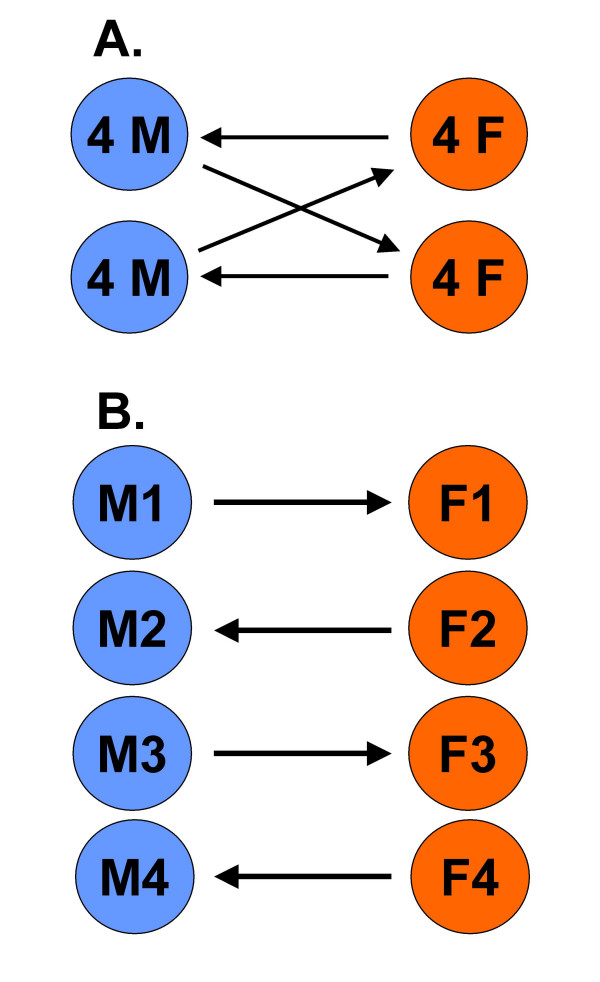
Experimental design. A total of 20 microarray hybridizations were performed, addressing biological variation through the use of 12 biologically independent samples for each sex, and technical variation through Cy3/Cy5 dye reversal as follows. (A) For each of the four embryonic stages (ed4, 6, 8 and 10), two samples per sex were generated by pooling equal amounts of total RNA from four individual male (M) or female (F) whole heads (ed4 and 6) or brains (ed8 and 10). Each RNA pool was converted to two cDNA samples, tagged with Cy3 and Cy5-capture sequence (Genisphere), respectively, and hybridized to two microarray slides, as illustrated by arrows. Arrowhead indicates Cy5-labeled sample. (B) For ed10, total RNA from four individual male (M) and female (F) brains were separately tagged with either Cy3 or Cy5-capture sequence during cDNA synthesis, and analyzed on four microarray hybridizations with dye-reversal as illustrated by arrows.